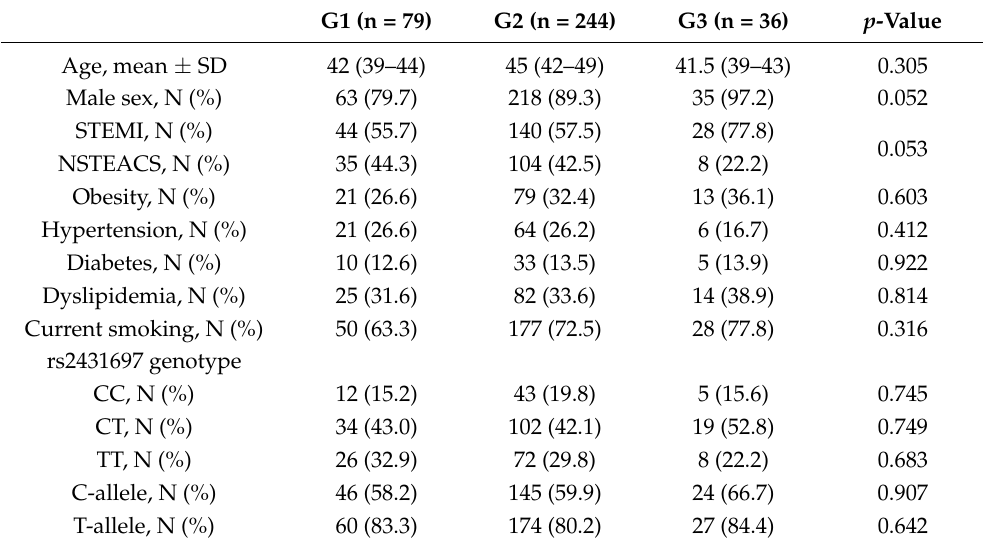
Table 2. Age, sex, main clinical characteristics and rs2431697 genotype of the ACS patients by